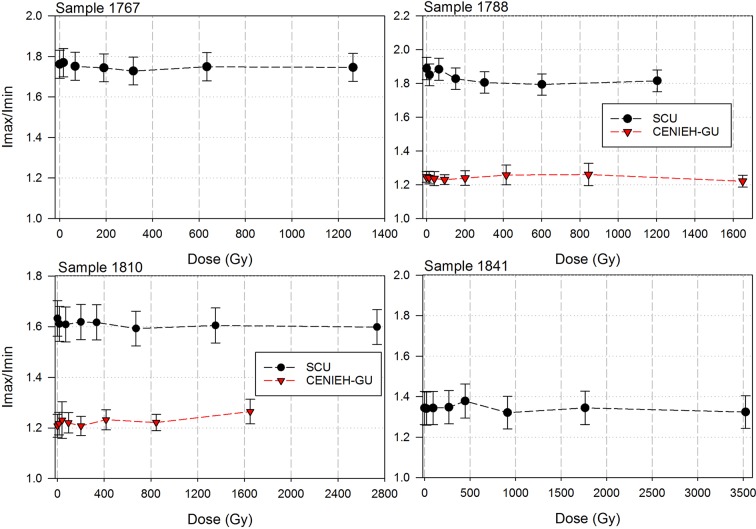
Evolution of the Imax/Imin ratio vs the irradiation dose for the four tooth samples.(see text for explanation).